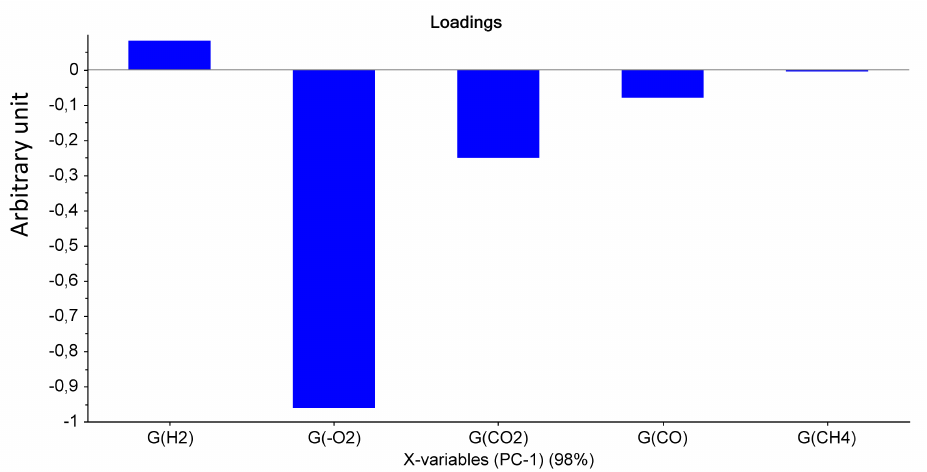
Figure 8. PCA loading for PC1 (Mod